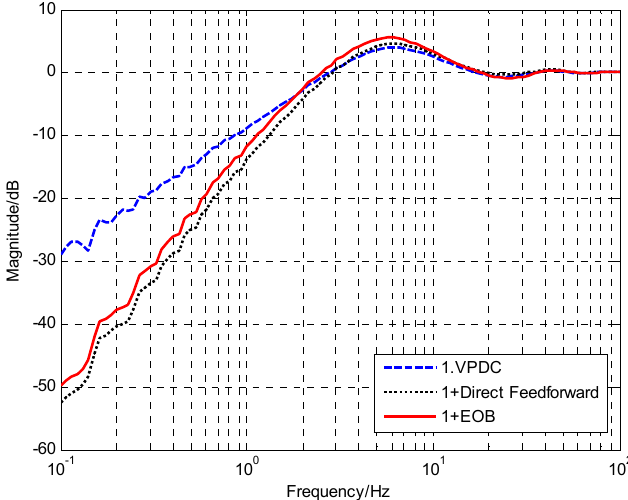
Figure 13. The error suppression response of the